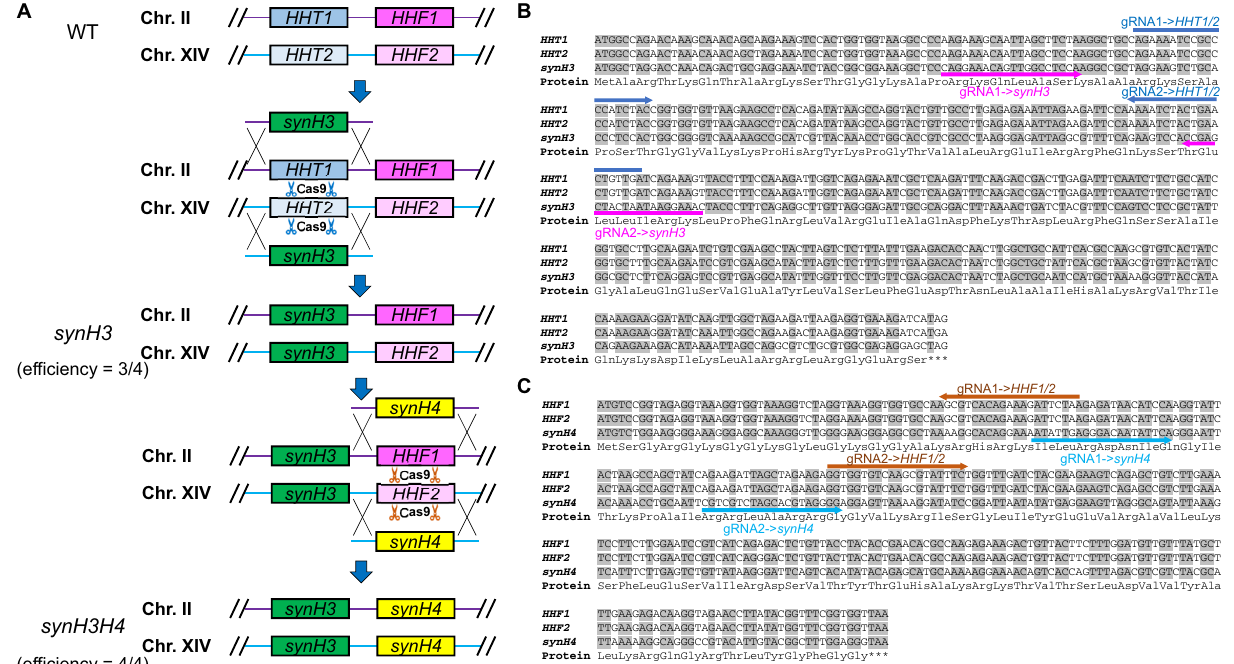
Figure 2. Generation of master shuffle strains with synthetic H3 and H4 by CRISPR-Cas9. ( A ) Generation of a master shuffle strain with synthetic H3 and H4 genes ( synH3H4 ) through 2 rounds of CRISPR-Cas9 mediated gene replacements. The efficiencies of 2 rounds are 3/4 (75%) and 4/4 (100%) respectively, which are tested by four randomly picked colonies respectively. ( B , C ) The nucleotide sequence alignment of endogenous and synthetic H3 and H4. The synthetic H3 and H4 (synH3 and synH4) share same protein sequences but different DNA codons with native H3 and H4 genes. The nucleotides with grey background indicate the identical nucleotide sequences. Dark blue arrows represent gRNA sequences targeting endogenous H3 ( HHT1/2 ); brown arrows represent gRNA sequences targeting endogenous H4 ( HHF1/2 ); magenta arrows represent gRNA sequences targeting synH3 genes, and light blue arrows represent gRNA sequences targeting synH4 genes . The gRNAs targeting synthetic histones are used for generating Histone H3 and H4 mutants in Figs. 3 and